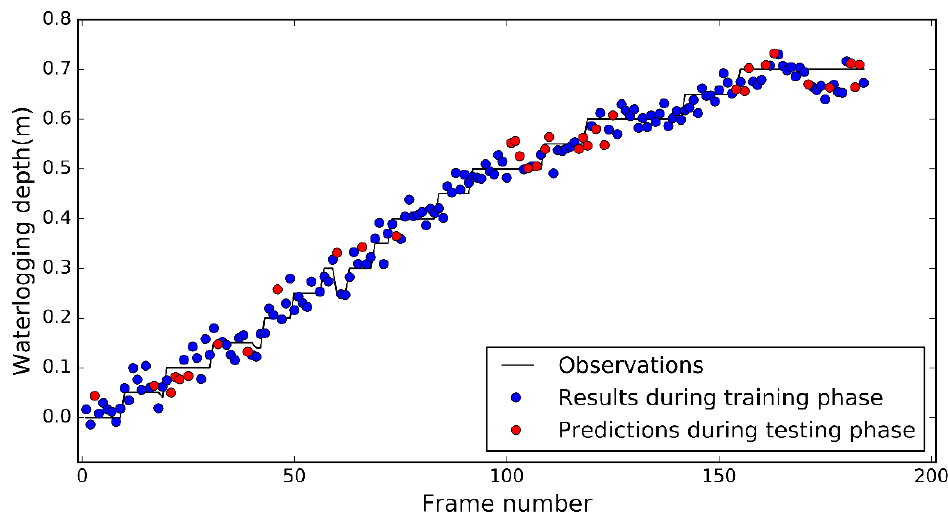
Figure 5. Observations vs. results and predictions during the training and testing phases for data set